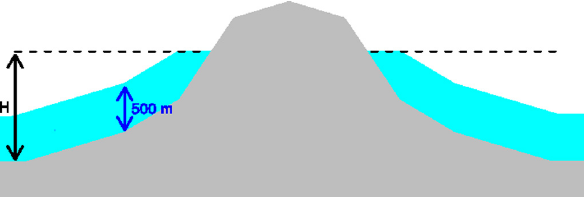
Fig. 5. Initialization of the ABL passive tracer: the blue layer is used for this purpose. It is defined as a 500m-deep terrain following layer, but limited at a ceiling altitude H = 1000m. The tracer was initialized to the arbitrary value 1000 in this blue layer, but zero above. During the model run, the tracer is refreshed at each time- step to 1000 in the blue layer, but outside it is freely advected and diffused by the model dynamics.